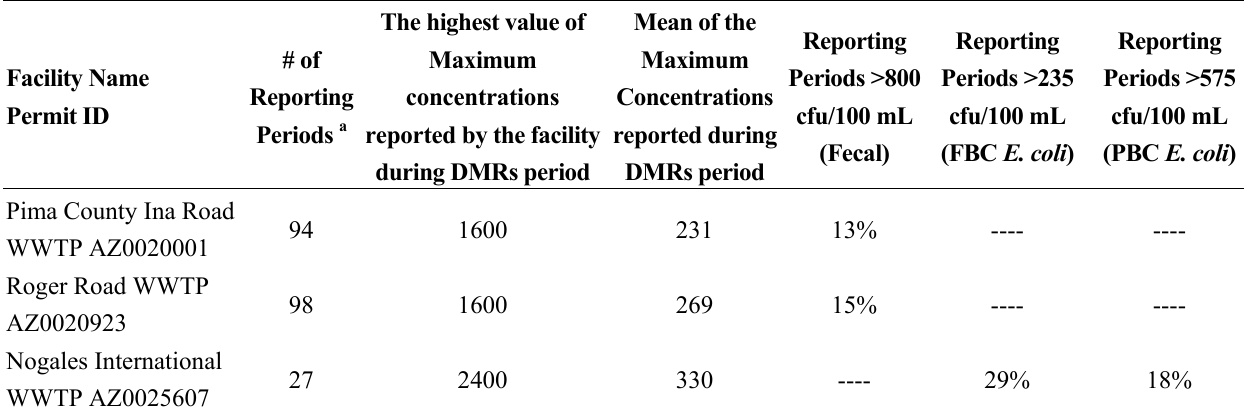
Table 2. Summary of the maximum concentrations reported for discharge monitoring reports (DMRs) period compared to the fecal coliform maximum standard of 800 cfu/100 mL for a single sample value or to the E. coli full body contact (FBC) maximum standard of 235 cfu/100 mL and to the 575 cfu/100 mL for partial body contact (PBC) for a single sample value.